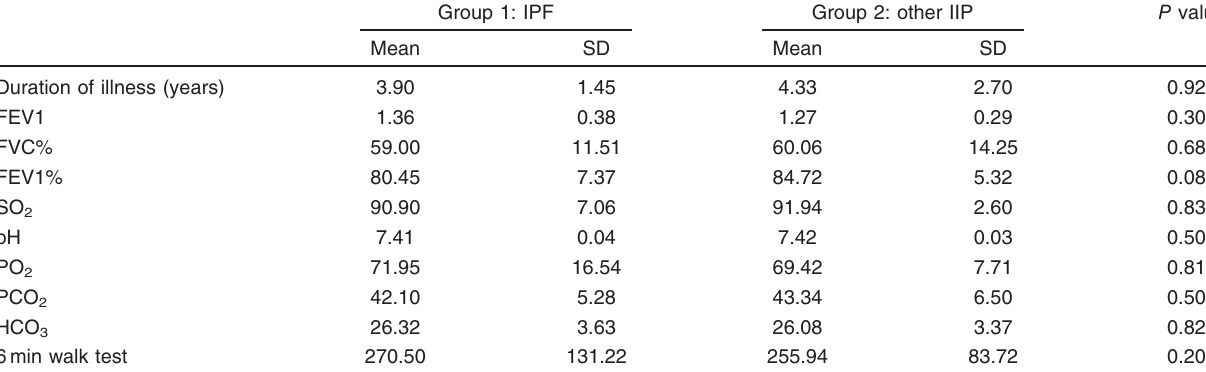
Table 3 Comparison between idiopathic pulmonary fibrosis and other idiopathic interstitial pneumonia groups regarding the duration of illness, spirometry, arterial blood gases, and 6min walk test